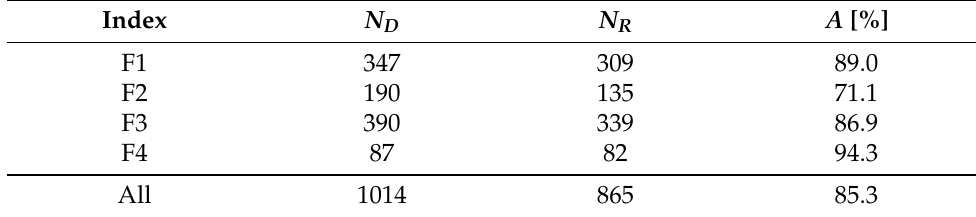
Table 7. Flight communication experiment